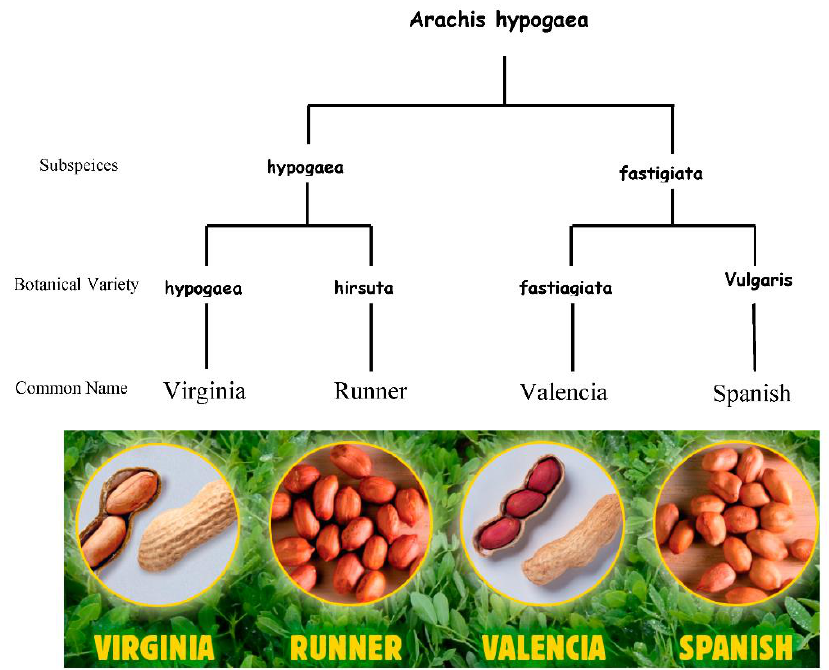
Figure 1. Image showing taxonomic arrangement of the four main subspecies of peanuts in the United States of America.